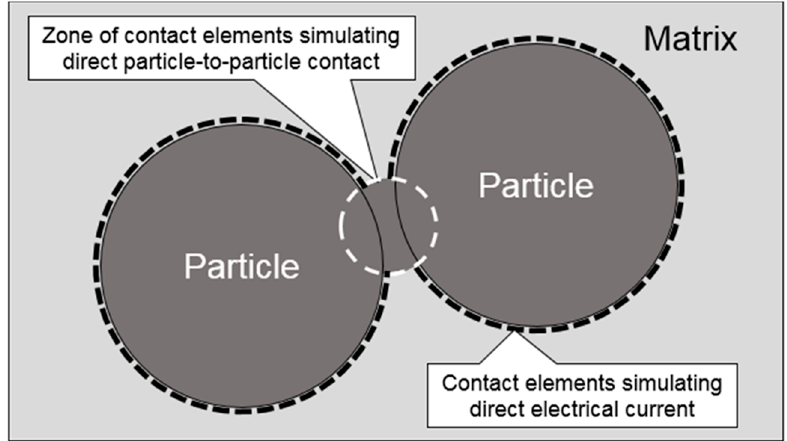
Figure 6. A schematic depicting the modeling approach for direct particle-to-particle electrical